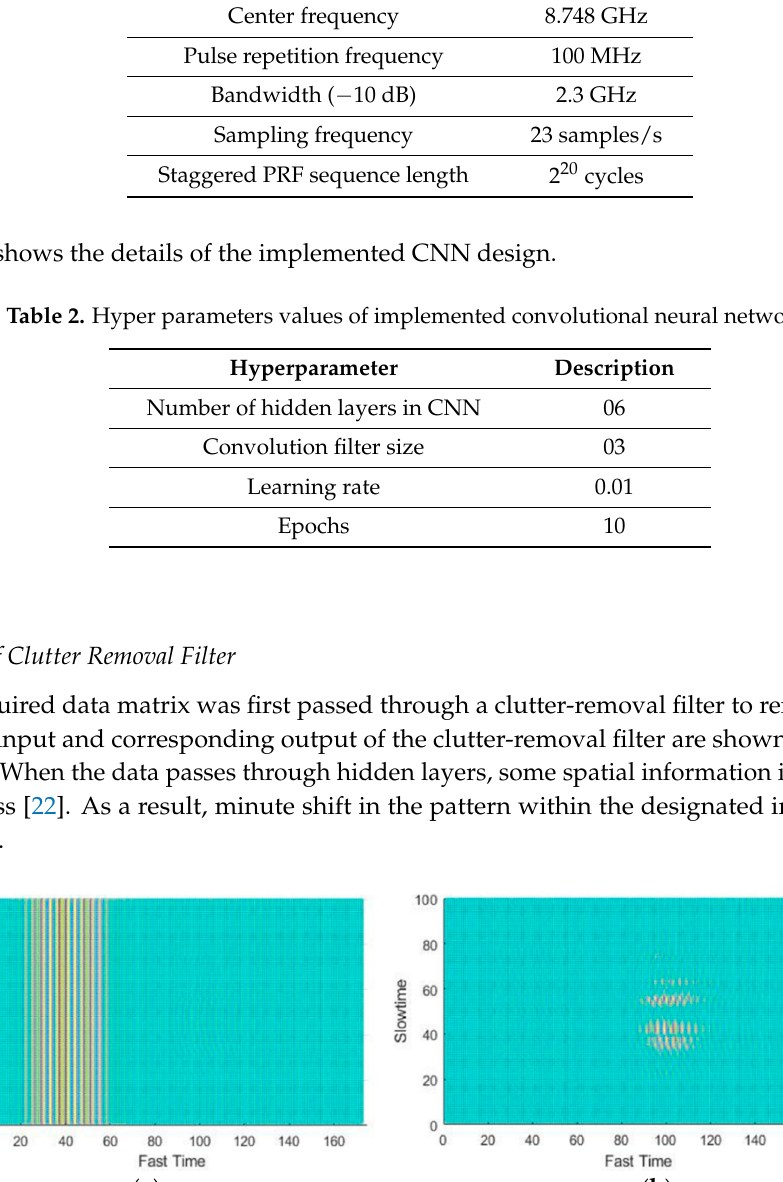
( b ) Figure 12. Clutter removal when radar placed near driver’s head: ( a ) signal before removal and ( b ) signal after removal.